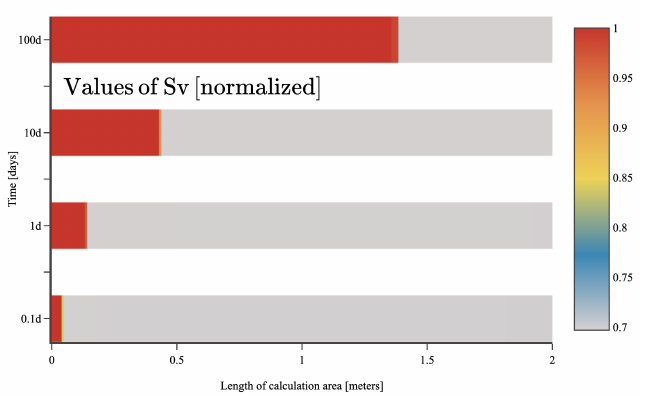
Figure 5. Hydrate thawing profile S ν in the area of the fault for the time moments t = 0.1, 1, 10, 100 days. X-axis: calculation length in horizontal direction of the reservoir is taken close to the fault (up to 2 m), where 0 X-value represents the